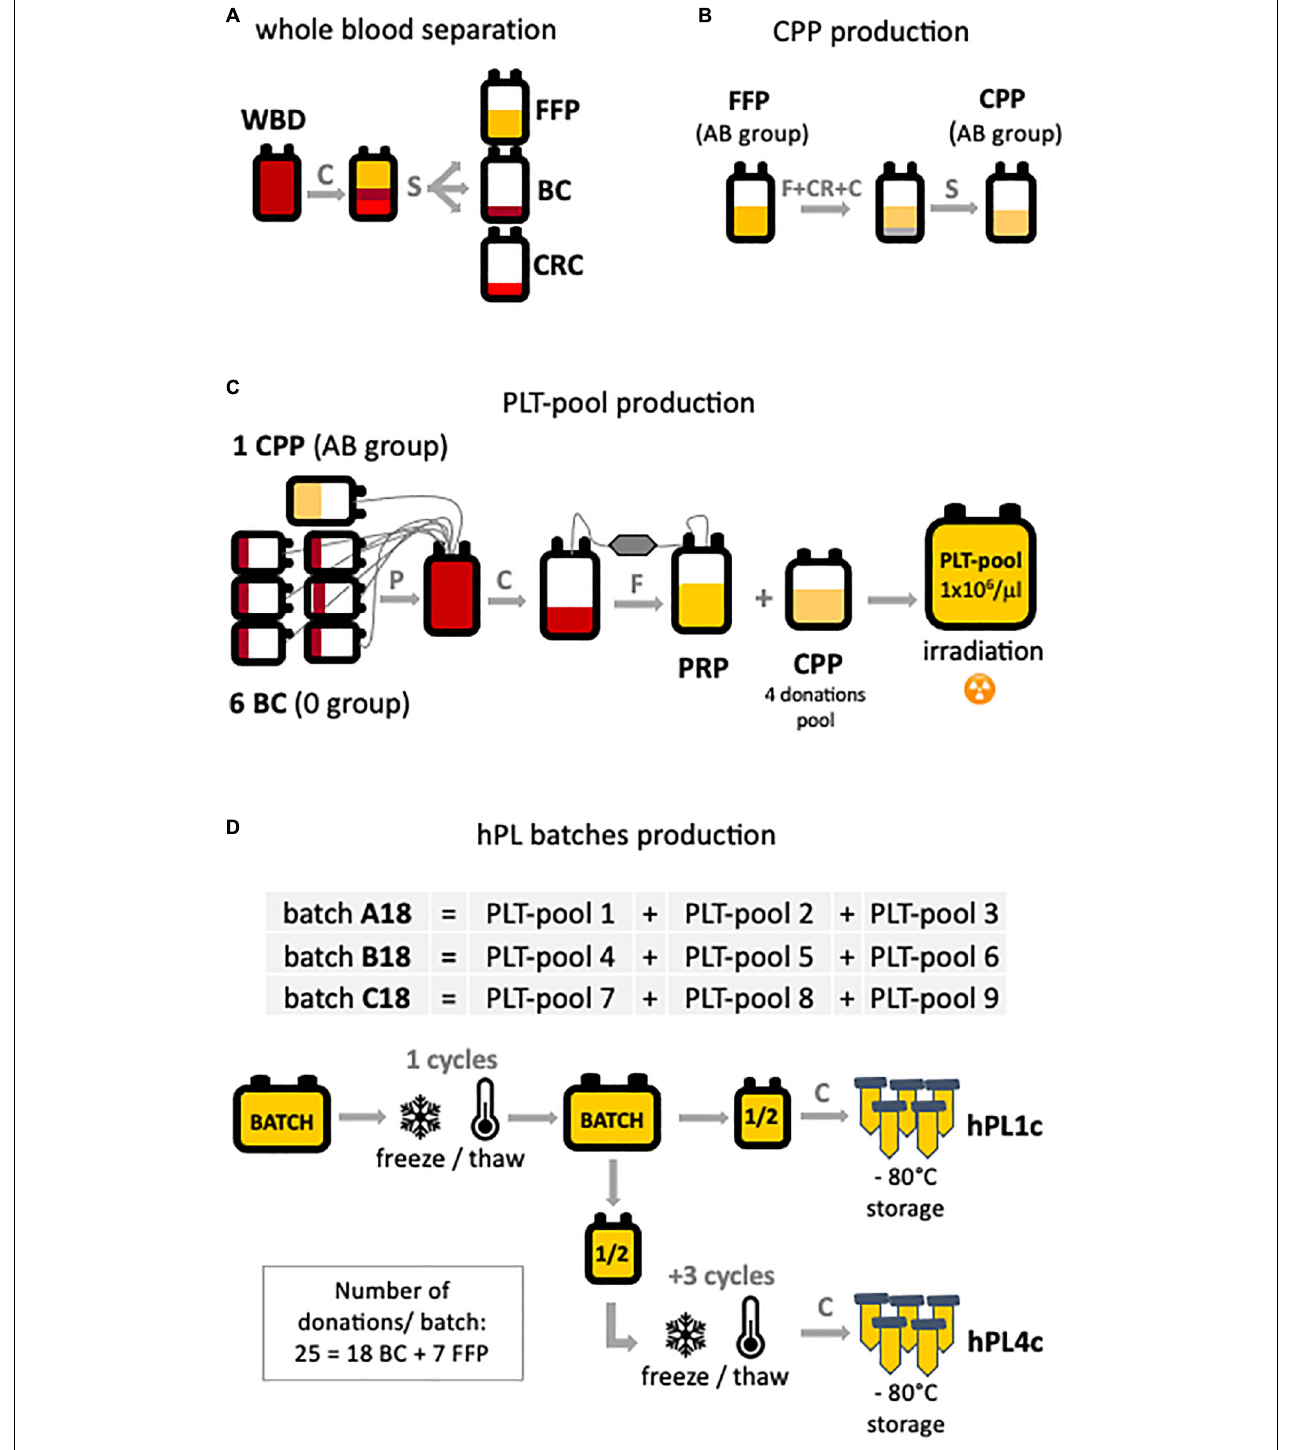
FIGURE 1 | hPL production scheme. The main production steps are highlighted: (A) starting from automatic separation of whole blood donation (WBD) in fresh frozen plasma (FFP), buffy coat (BC), and concentrated red cell (CRC) units. (B) Cryoprecipitate-poor plasma (CPP) is obtained by removing the cryoglobulin fraction of the plasma from FPP. (C) Platelet-rich plasma (PRP) is the product of the processing of six BC and one CPP. To obtain the platelet pool (PLT pool), platelet concentration was diluted to 1 × 10 6 PLT/ µ l with CPP. (D) Three batches (A–B–C18) of human platelet lysate (hPL) were produced. Each batch is the result of three PLT pools assembled and subjected to one or four freeze/thaw cycles. For each batch, both hPL with one freeze–thaw cycle (hPL1c) and hPL with four freeze–thaw cycles (hPL4c) were produced. After debris removal, hPL was sterile aliquoted and stored at –80 ◦ C until use. C, centrifugation; CR, cryoprecipitation; F, filtration; P, pooling; S,